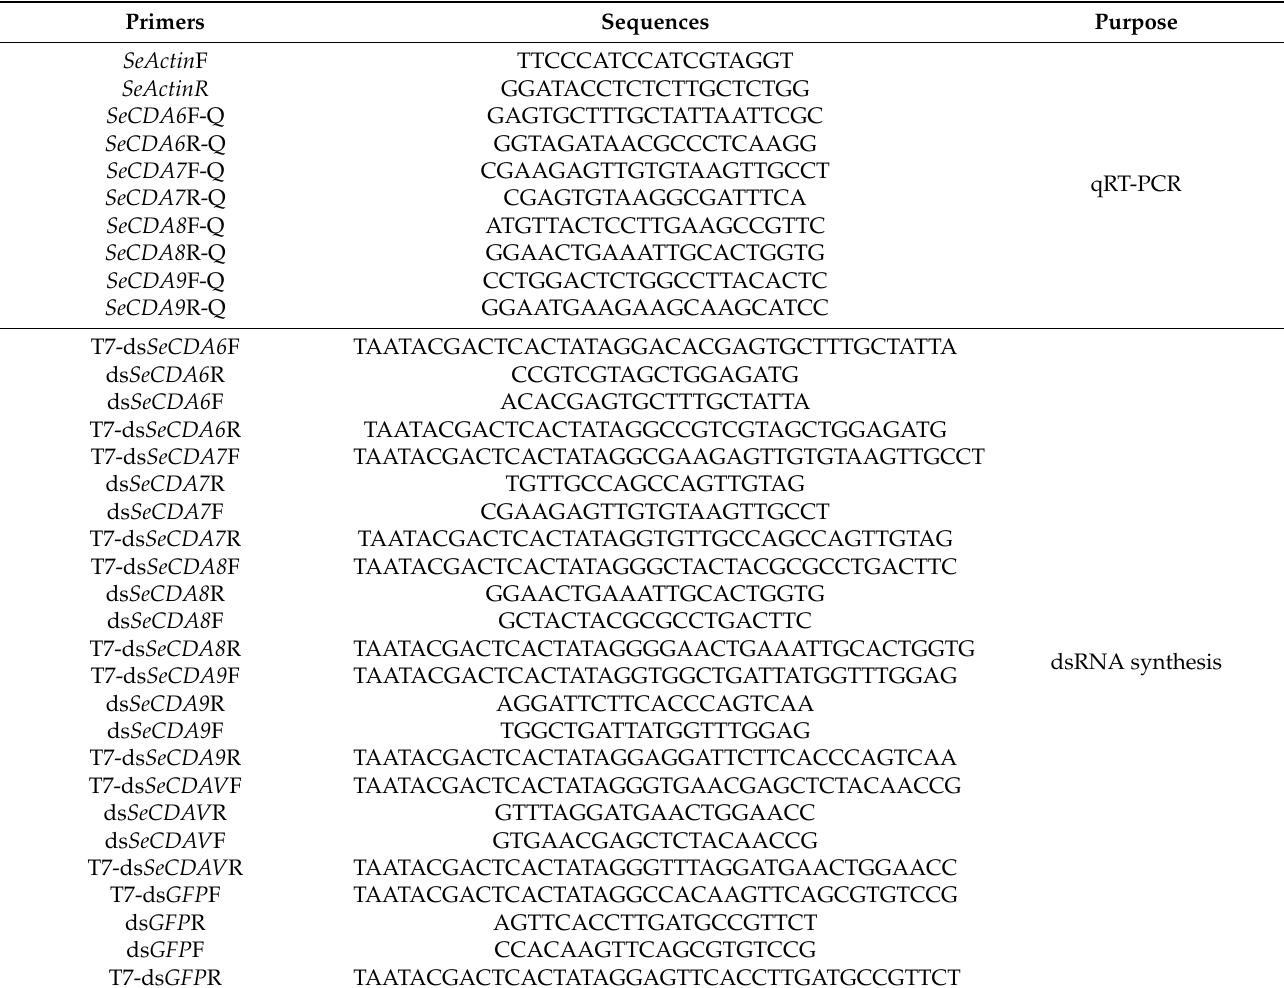
Table 2. The melting curve was determined for each sample to detect the gene-specific peak and verify the absence of primer dimers. qRT-PCR was carried out in a 20 µ L reaction volume containing 1 µ L of cDNA, 10 µ M of each primer, 7 µ L of H 2 O and 10 µ L of TB Green ® Premix Ex Taq™ II (Tli RNaseH Plus), ROX plus (TaKaRa, Beijing, China). PCR was conducted on a CFX-96 real-time PCR detection system (Bio-Rad, Hercules, CA, USA). The amplifications were performed using an Eppendorf thermocycler. They comprised an initial denaturation step at 95 ◦ C for 3 min, followed by 39 cycles at 95 ◦ C for 15 s, 55 ◦ C for 30 s and 72 ◦ C for 30 s, and a final extension step of 5 min at 72 ◦ C. Relative transcript levels of target genes ∆∆ Ct were calculated with the 2 − method. Three biological repeats, each with three technical replicates, were set for each cDNA, and β -actin was used as the internal reference gene to calibrate the total amount of RNA. β -actin proved to be a suitable housekeeping gene applied in the qRT-PCR of S. exigua in our previous study [46]. The amplification efficiencies of the target and reference were approximately equal (Supplementary Figure S5). The significance of differences between samples was assessed using SPSS 22.0 software (SPSS Inc., Chicago, IL, USA), and the data were presented as means and standard errors (SE). Table 2. Primers used in this